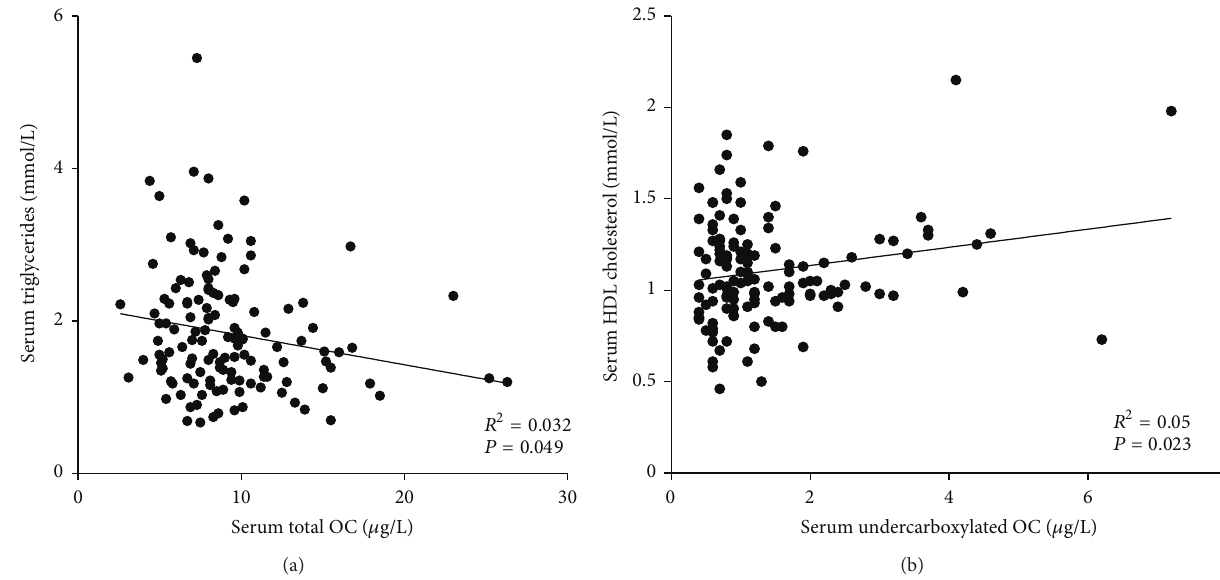
Figure 2: Scatter plot and regression analysis of serum TOC and uOC levels with serum triglycerides and serum HDL-cholesterol levels, respectively, within the group of individuals with the metabolic syndrome. The serum TOC was significantly and negatively correlated with serum triglycerides ( 𝑅 2 = 0.032 , 𝑃 = 0.049 ), whereas uOC significantly correlated with serum HDL-cholesterol levels ( 𝑅 2 = 0.05 , 𝑃 = 0.023 ).